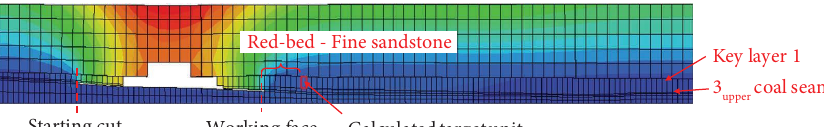
Figure 8: Schematic diagram of target element for calculating strain